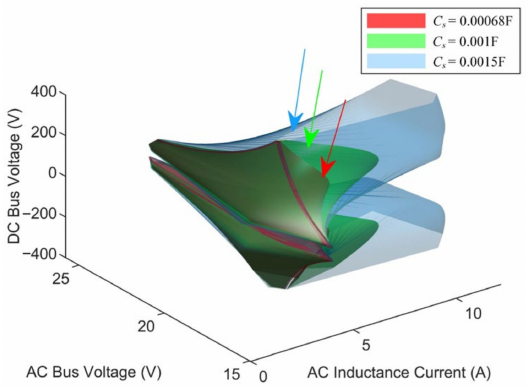
Figure 26. Different 3D RAS of microgrids when AC capacitors are 0.00068 F, 0.001 F and 0.0015